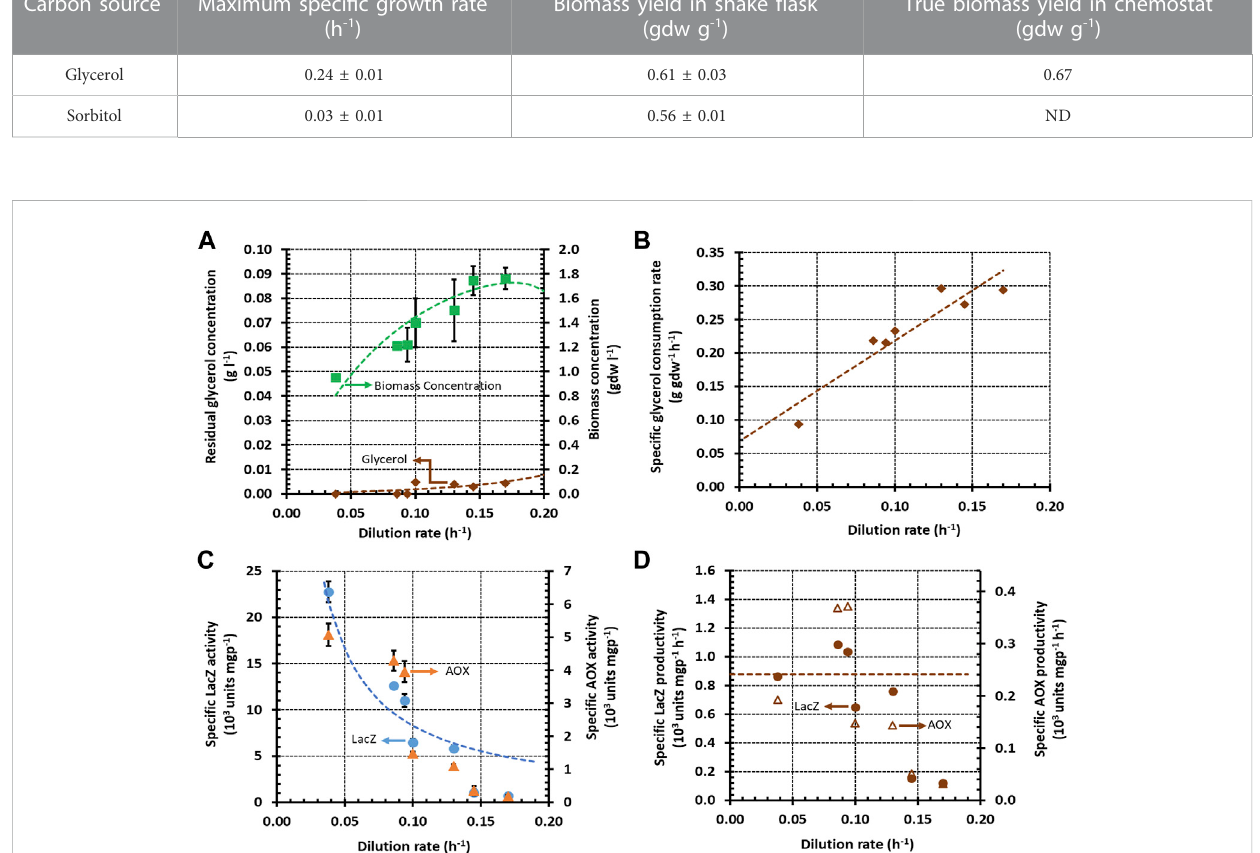
FIGURE 1 Variation of steady state concentrations and rates with the dilution rate during growth of K. phaf fi i strain Mut + (pSAOH5-T1) in a chemostat fed with glycerol (~3.1 g L − 1 ). (A) Concentrations ofbiomass and residual glycerol. (B) Speci fi cglycerol consumptionrates calculated fromthedata in (A) using Eq. 5. (C) Speci fi c activities of LacZ and AOX. (D) Speci fi c Lac Z and AOX productivities calculated from the data in (C) using Eq.